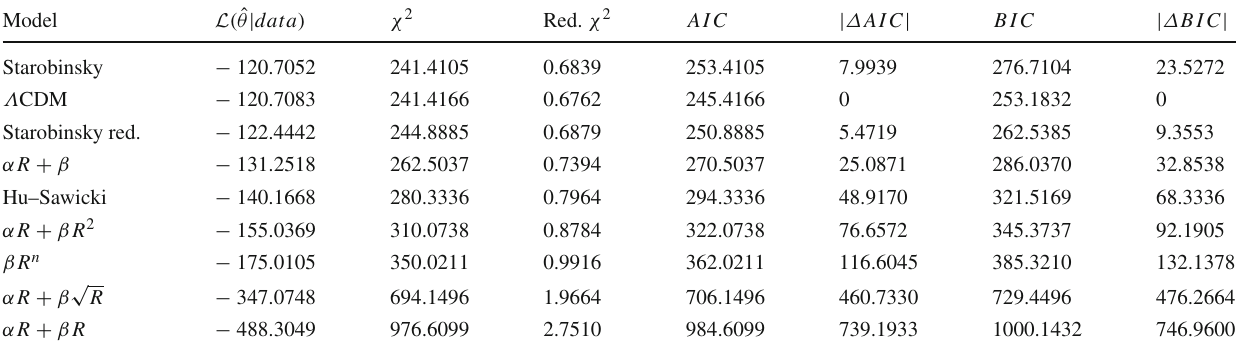
Table2 Thebestfitforeachtestedmodel,includingthe Λ CMDmodel. The models are listed in the order from the largest likelihood function value L ( ˆ θ | data ) to the smallest likelihood of being viable. The reduced χ 2 -values are given as an indication of the goodness of fit for a particu-